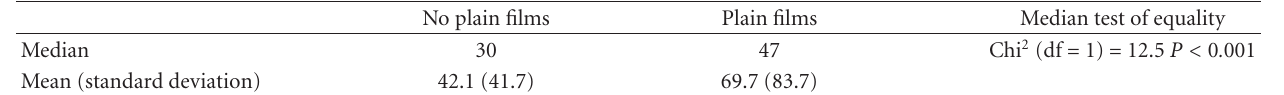
Table 2: Time from arrival to whole-body CT (minutes).